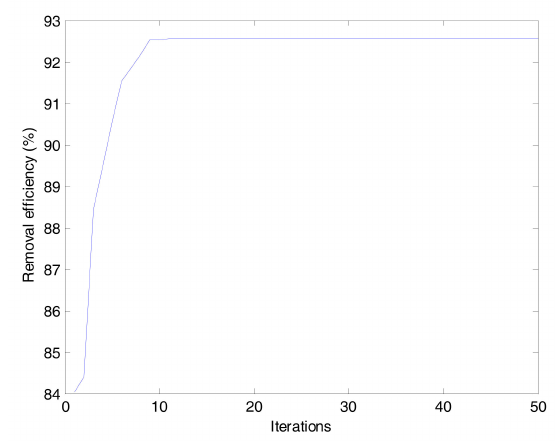
Figure 15. The removal efficiency vs. iterations.